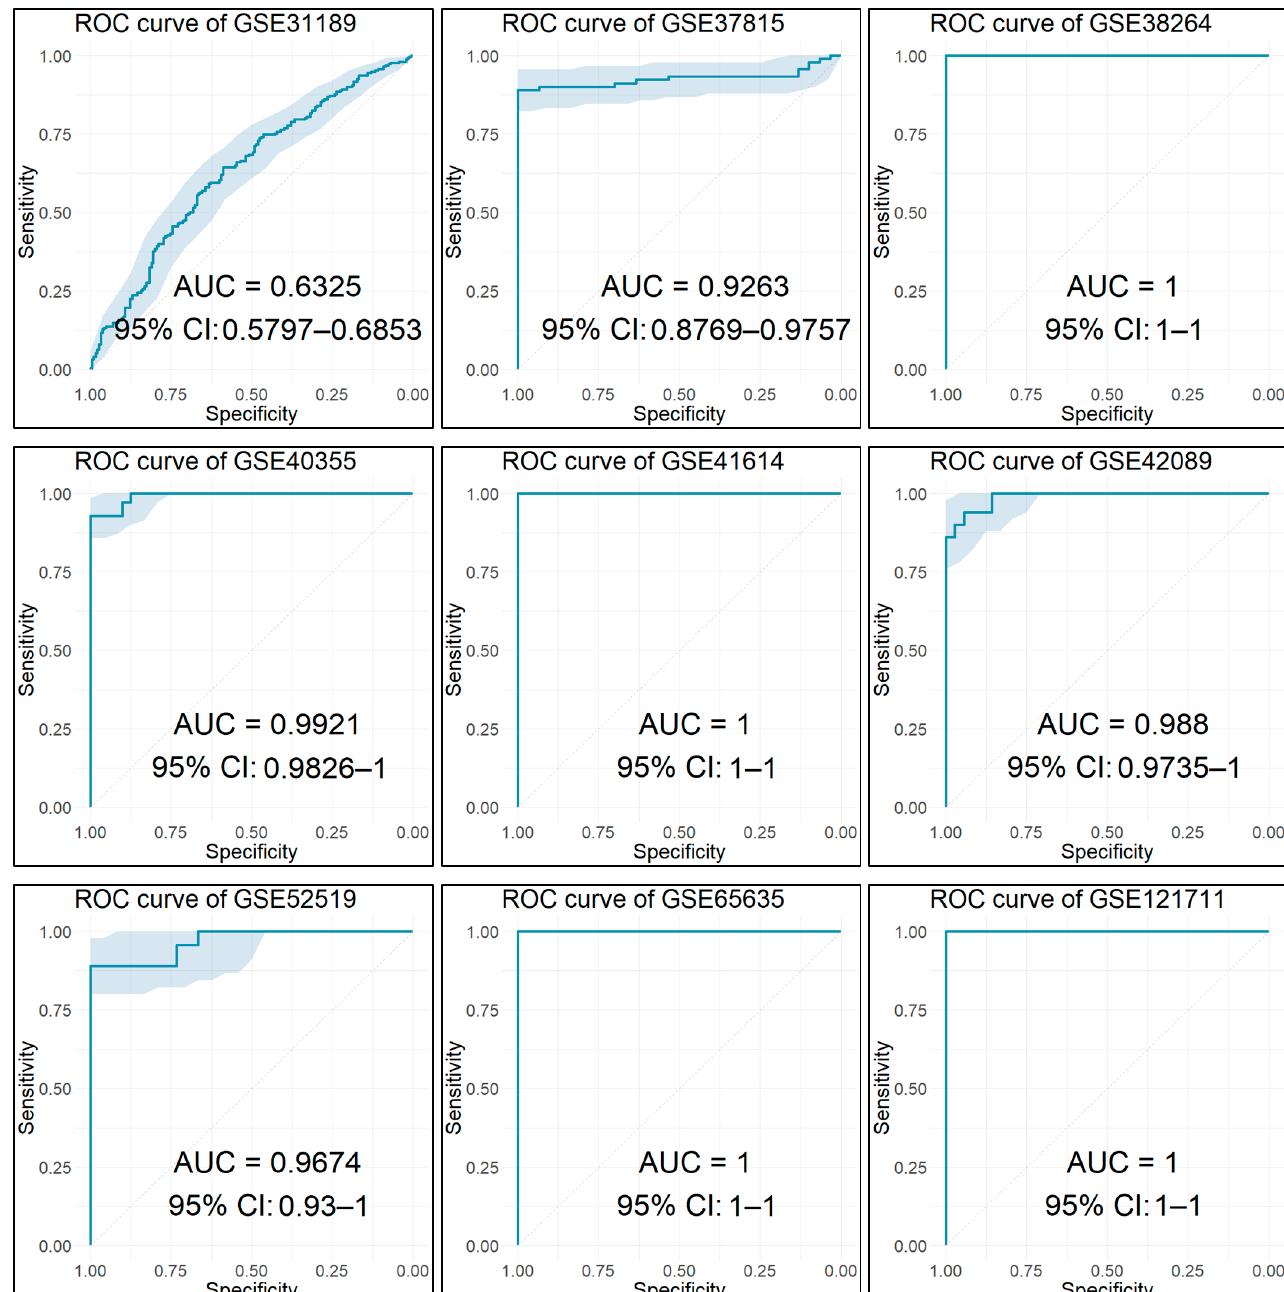
Figure 29. Validation of the diagnostic models, using the nine key biomarker genes as features, by ROC curve analysis on each of the datasets included in our integrative meta-analysis and contained at least 10 samples (see Table 1).